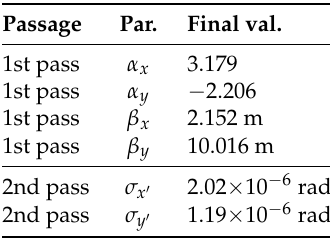
Table 3. Beam parameters obtained with the matching line after the first and the second passage. Passage